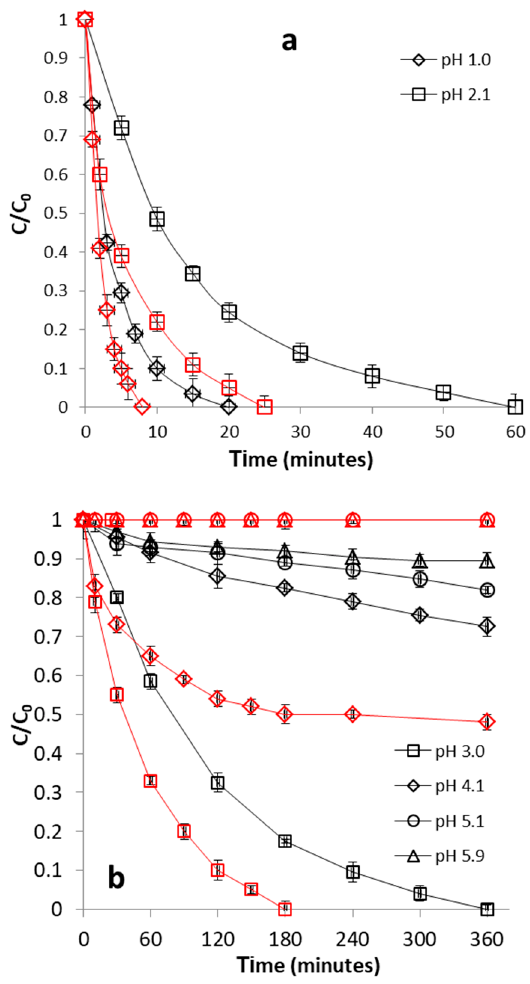
Figure 9. Effect of pH on Cr VI removal by WSP-Fe 0 (red curves) and WSP (black curves). ( a ) pH 1.0– 2.1; ( b ) pH 3.0–5.9. The lines are not fitting models; they simply connect points to facilitate